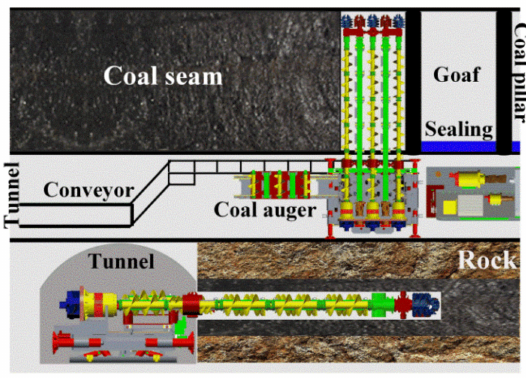
Figure 1. Mining technology of coal auger.